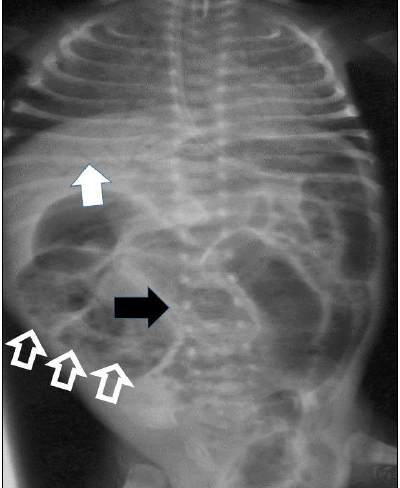
Figure7: Pneumatosis intestinalis in a patient of NEC. White arrow showed portal venous gas. Black arrow linear or string sign. Hollow white arrow showed soap bubble sign. Prone cross table lateral view